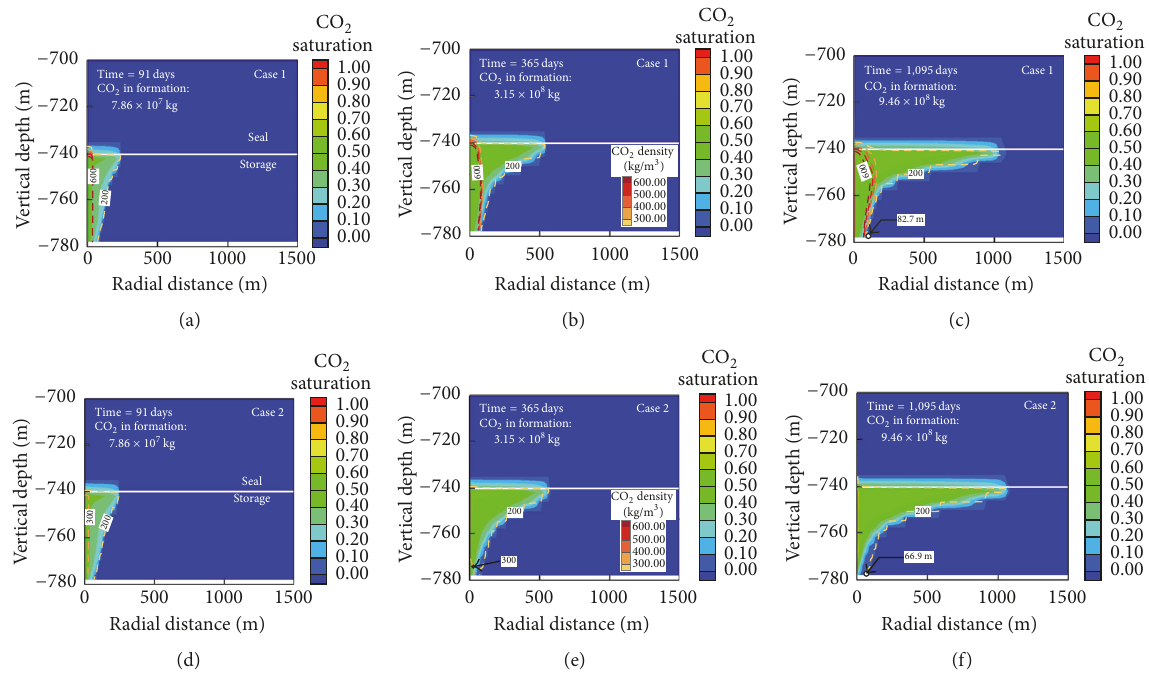
Figure 4: Distribution of CO 2 saturation [-] shown as color contours and CO 2 density [kg/m 3 ] as dashed lines at a series of times (91, 365, 1,095 days). (a), (b), and (c) were simulated from the EPM model (Case 1 ) while (d), (e), and (f) were from the WR model (Case 2 ). The isodense lines represent the magnitude of density which follows the legend shown in (b) and